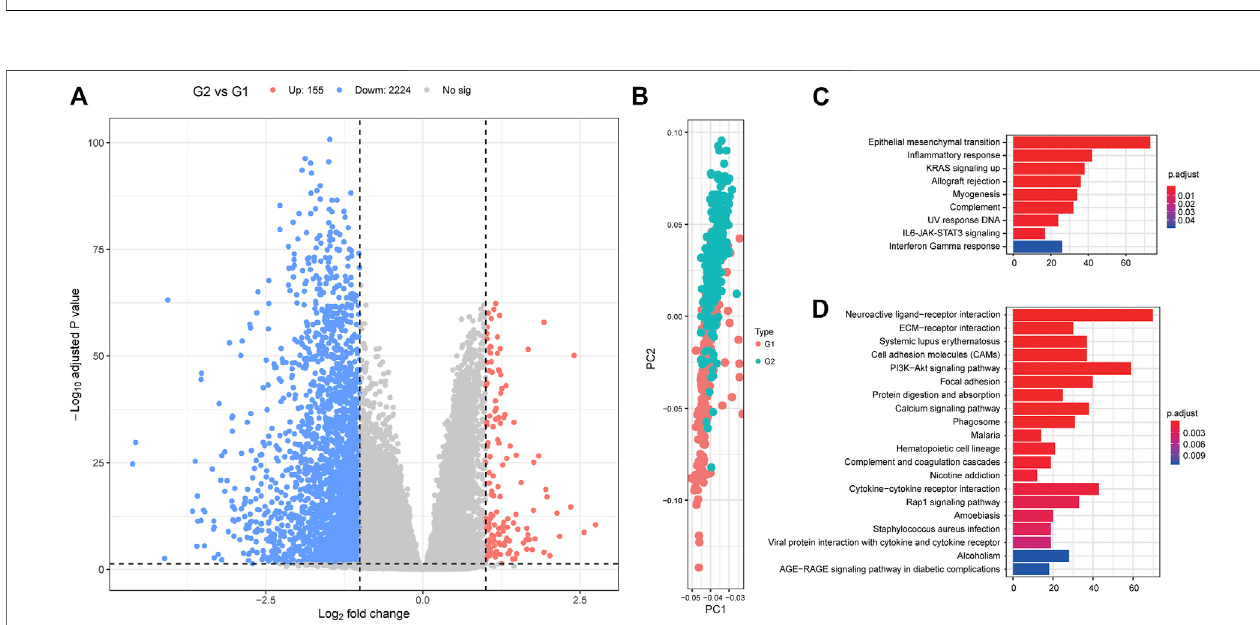
FIGURE 5 | The differentially expressed genes between G1 and G2 subgroups. (A) Volcano plot displaying the differentially expressed genes between G2 and G1 subgroups. (B) Principal component analysis (PCA) analysis describing the differences in clustering between the G1 and G2 subgroups. Hallmark (C) and Kyoto EncyclopediaofGenesandGenomes(KEGG) (D) analysesforthedifferentiallyexpressedgenes.G2:aggressive(higher-risksurvival)subtype;G1:moderate(lower-risk survival) subtype.